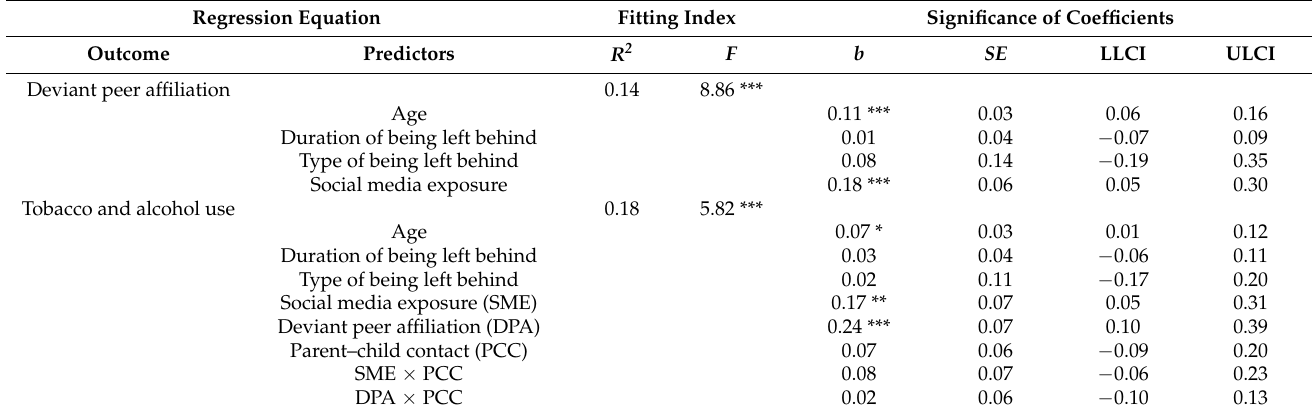
Table 2. Testing the moderated mediation effects among left-behind